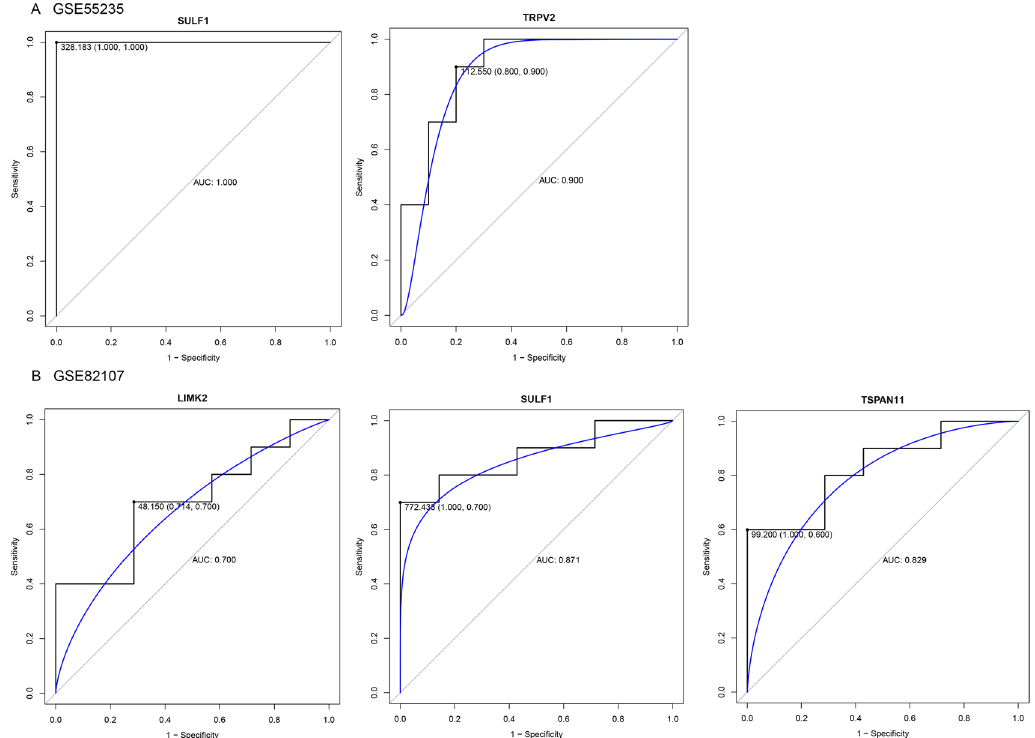
Fig. 6 The ROC curves of DEmRNAs and DElncRNAs in GSE55235 ( A ) and GSE82107 ( B ) databases. The x-axes show 1-specificity (the proportion of false positives) and y-axes show sensitivity (the proportion of true